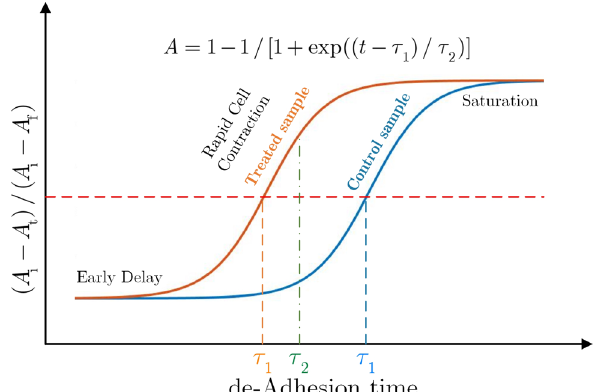
Figure 2. The normalized cell surface area versus de-adhesion time for treated and untreated (control) cells.